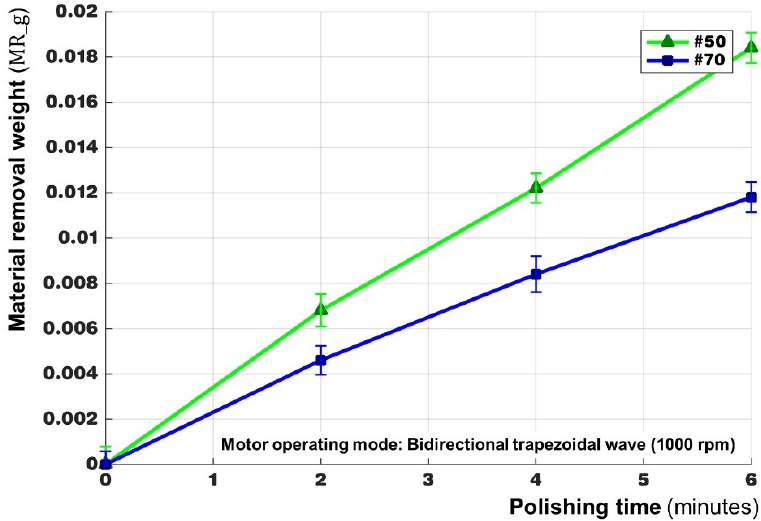
Figure 12. Comparison chart of average material removal weight and polishing time of two kinds of steel particle size.